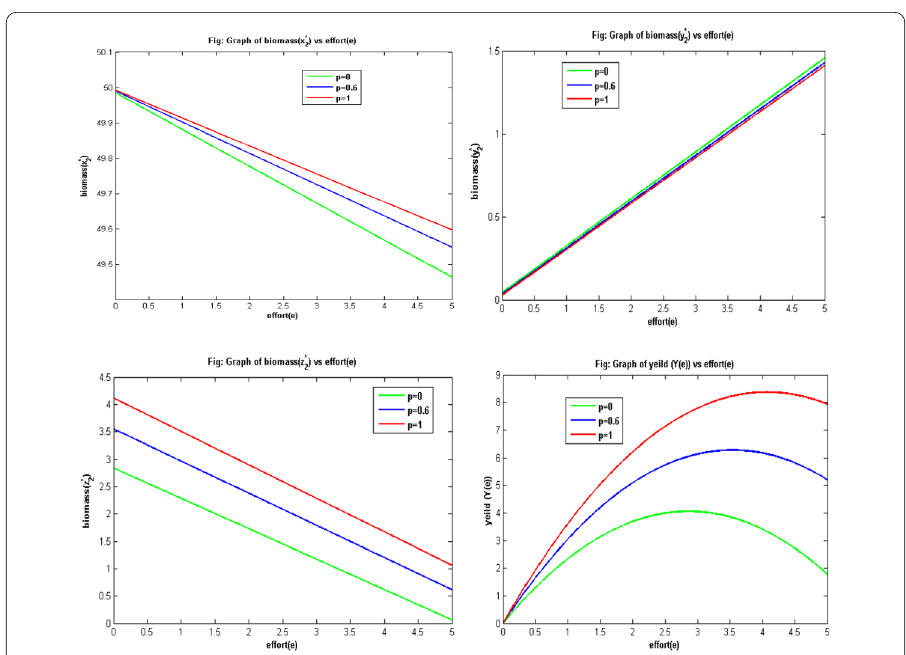
Figure 12 The changes in the population biomass and total yield with respect to the change in harvesting effort e in the range [0,5]. Here the value of parameter p has been varied in three different levels ( p =